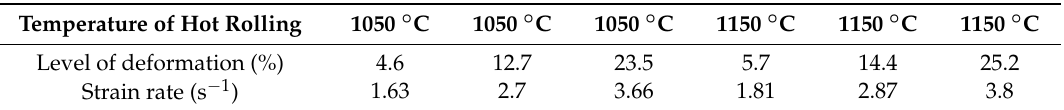
Table 2. Temperature of hot rolling and level of deformation and average strain rate achieved during hot